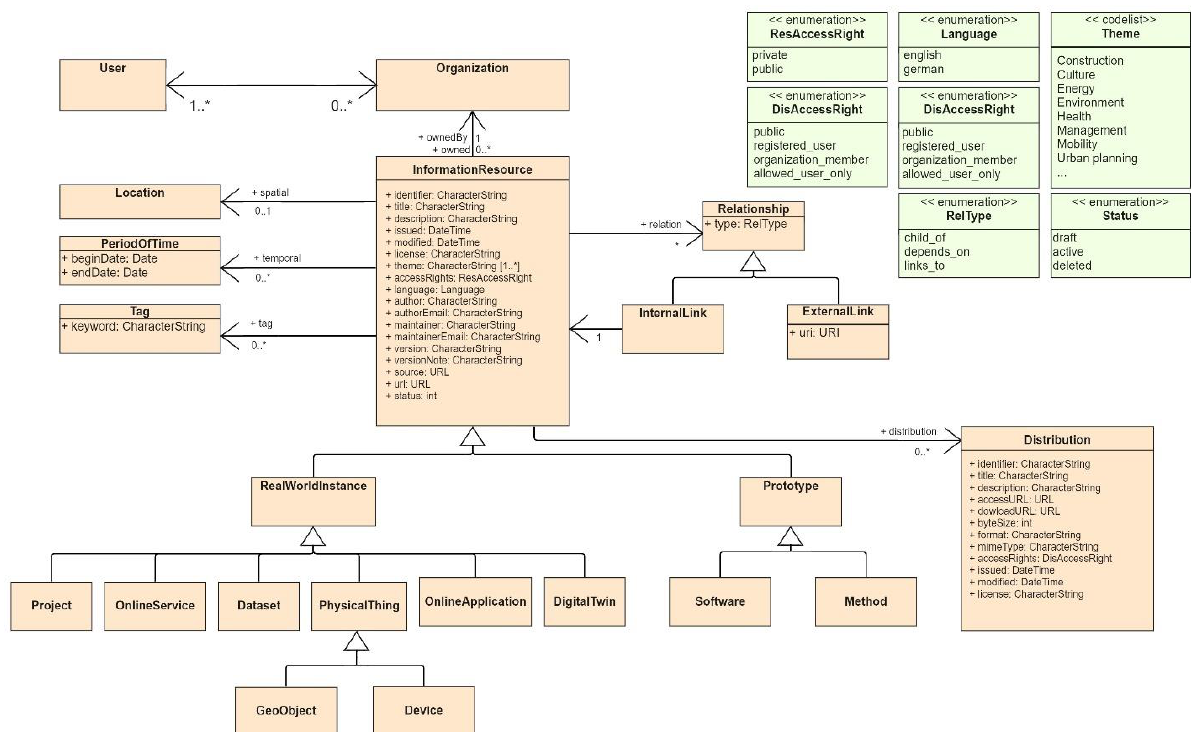
Figure 1: UML Class diagram - Generalized overview of the metadata model of the Urban Digital Twin. This is an adapted version from (Moshrefzadeh et al. 2020) extended by the subclasses RealWorldInstance , Prototype , and DigitalTwin